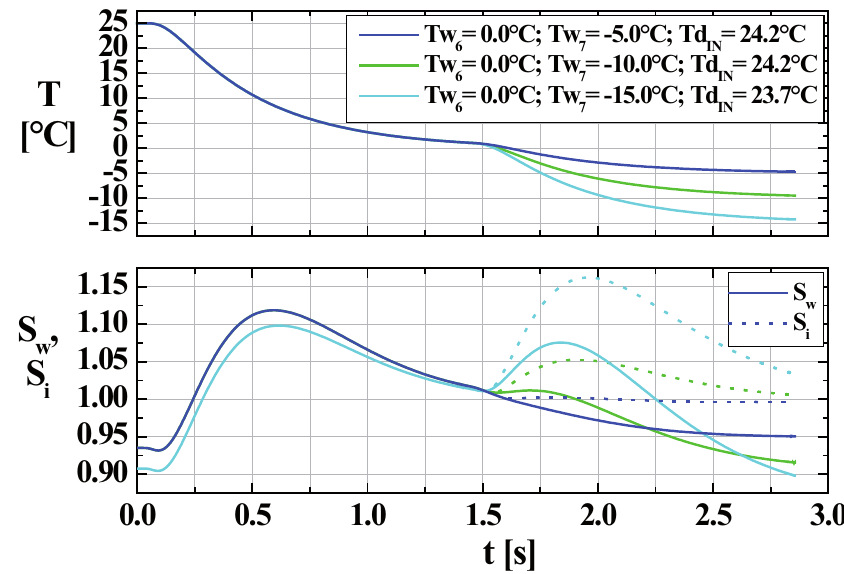
Fig. 2. Temperature T (upper panel) and saturation with respect to liquid water S w (solid lines, lower panel) and ice S i (dotted lines, lower panel) at the centerline of LACIS as function of residence time t in Sect. 6 and 7 for different boundary conditions (wall temperature T w and inlet dew point temperature T d , IN